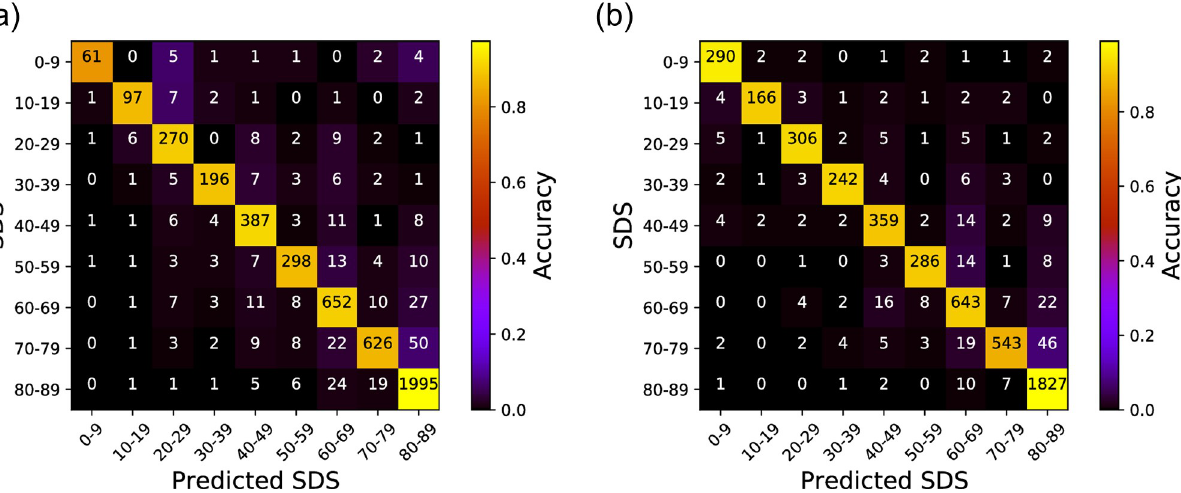
Fig 6. Confusion matrix for the SDS prediction performance with a range of 0-90 only. The X-axis shows the predicted SDS and the Y-axis shows the ground-truth. The numbers in the matrix present the number of prediction occurrences. An ideal confusion matrix would have bright colors (high occurrence counts) diagonally. (a) Left ear, (b) Right